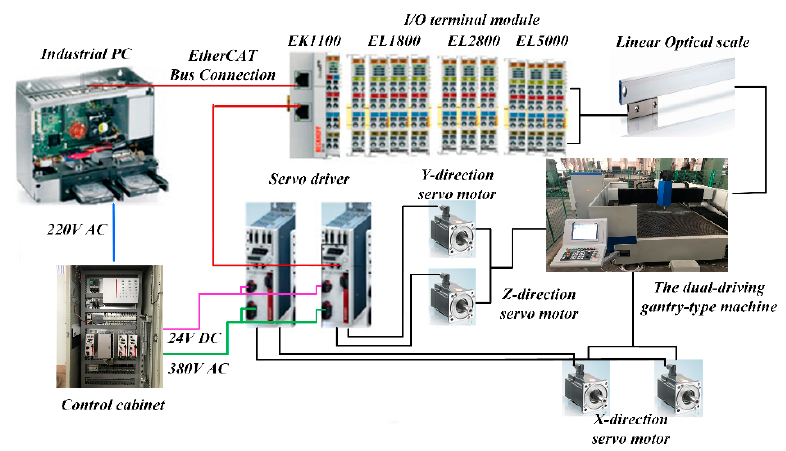
Figure 6. The overall hardware architecture of the DDGTMT.